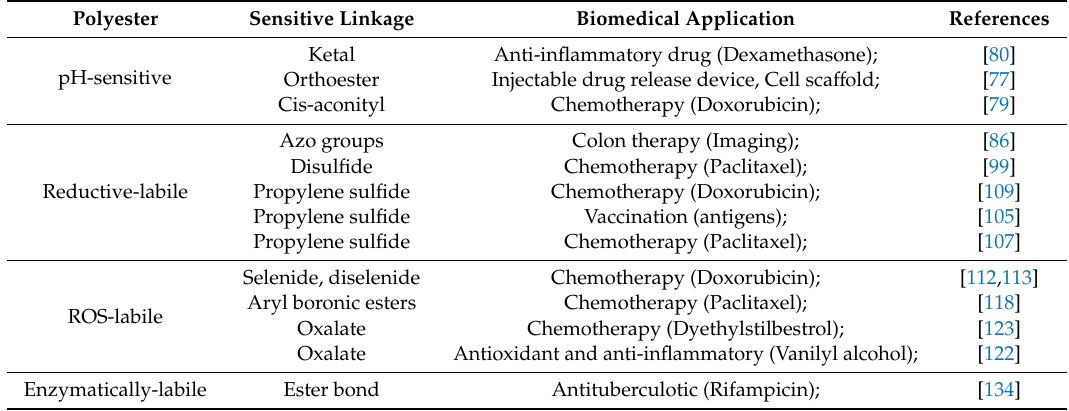
Table 2. Selectively biodegradable polyesters and their biomedical applications.